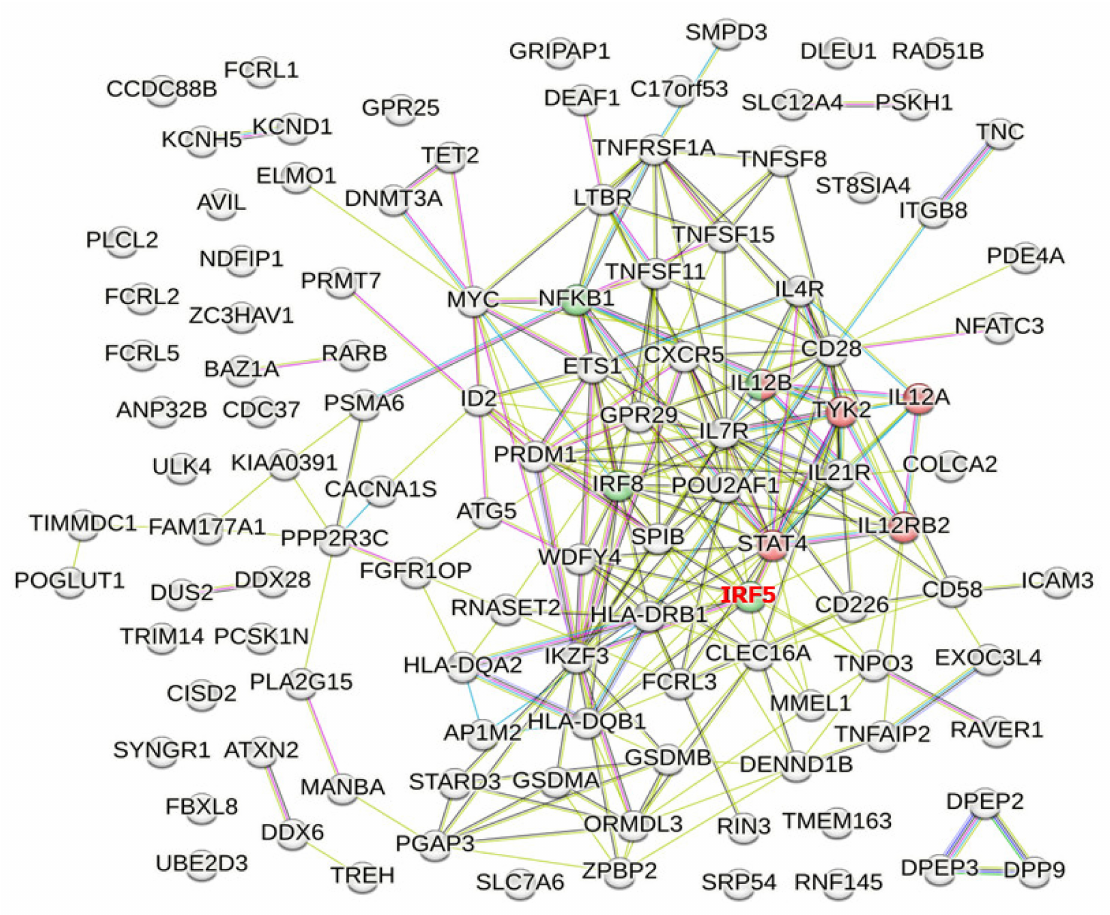
Figure 2. PBC susceptibility mapped genes and e-QTL genes whose protein products are involved in Gene Ontology (GO) pathways related to “IL-12-mediated signaling.” Among 59 PBC susceptibility mapped genes and 60 e-QTL genes, those defined in the GO database as “Interleukin-12-mediated signaling pathway (GO: 0035722)” and “Regulation of interleukin-12 production (GO: 0032655)” are shown as red and green nodes, respectively. However, after removal of “the e-QTL gene but not the mapped gene” (gene name shown in red), “Regulation of interleukin-12 production (GO: 0032655)” in the Gene Ontology database did not reach a level of statistical significance when using PBC susceptibility genes